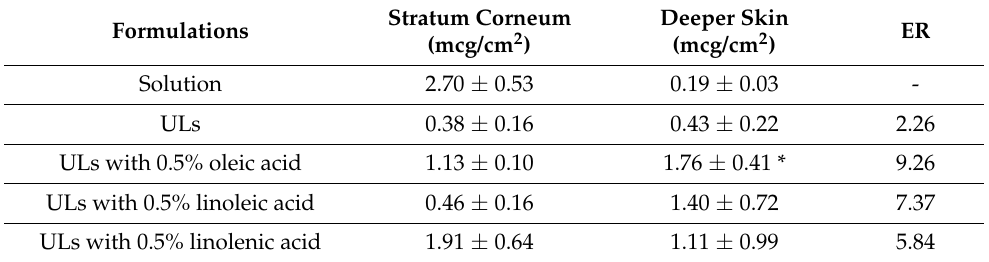
Table 3. Skin penetration parameters of rosmarinic acid from each formulation.